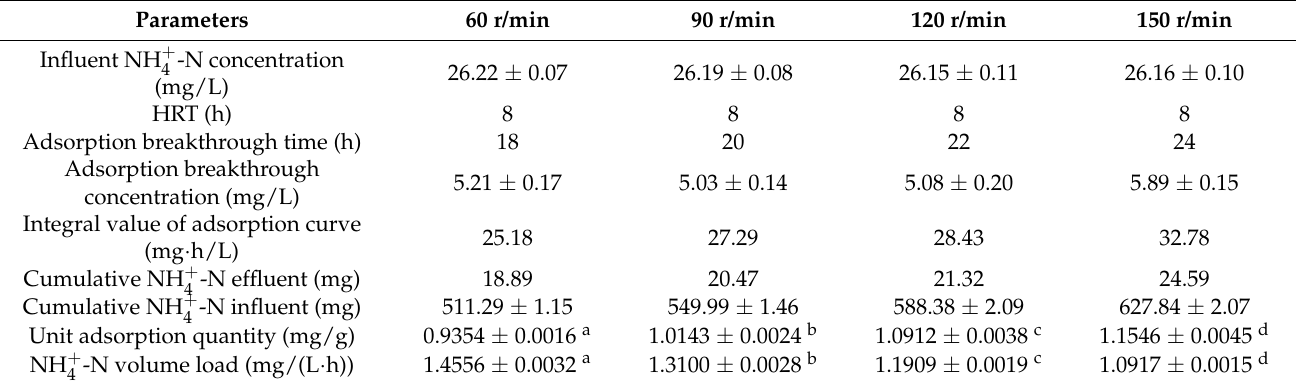
Table 3. Adsorption parameters of the MBBR with different stirring intensities.